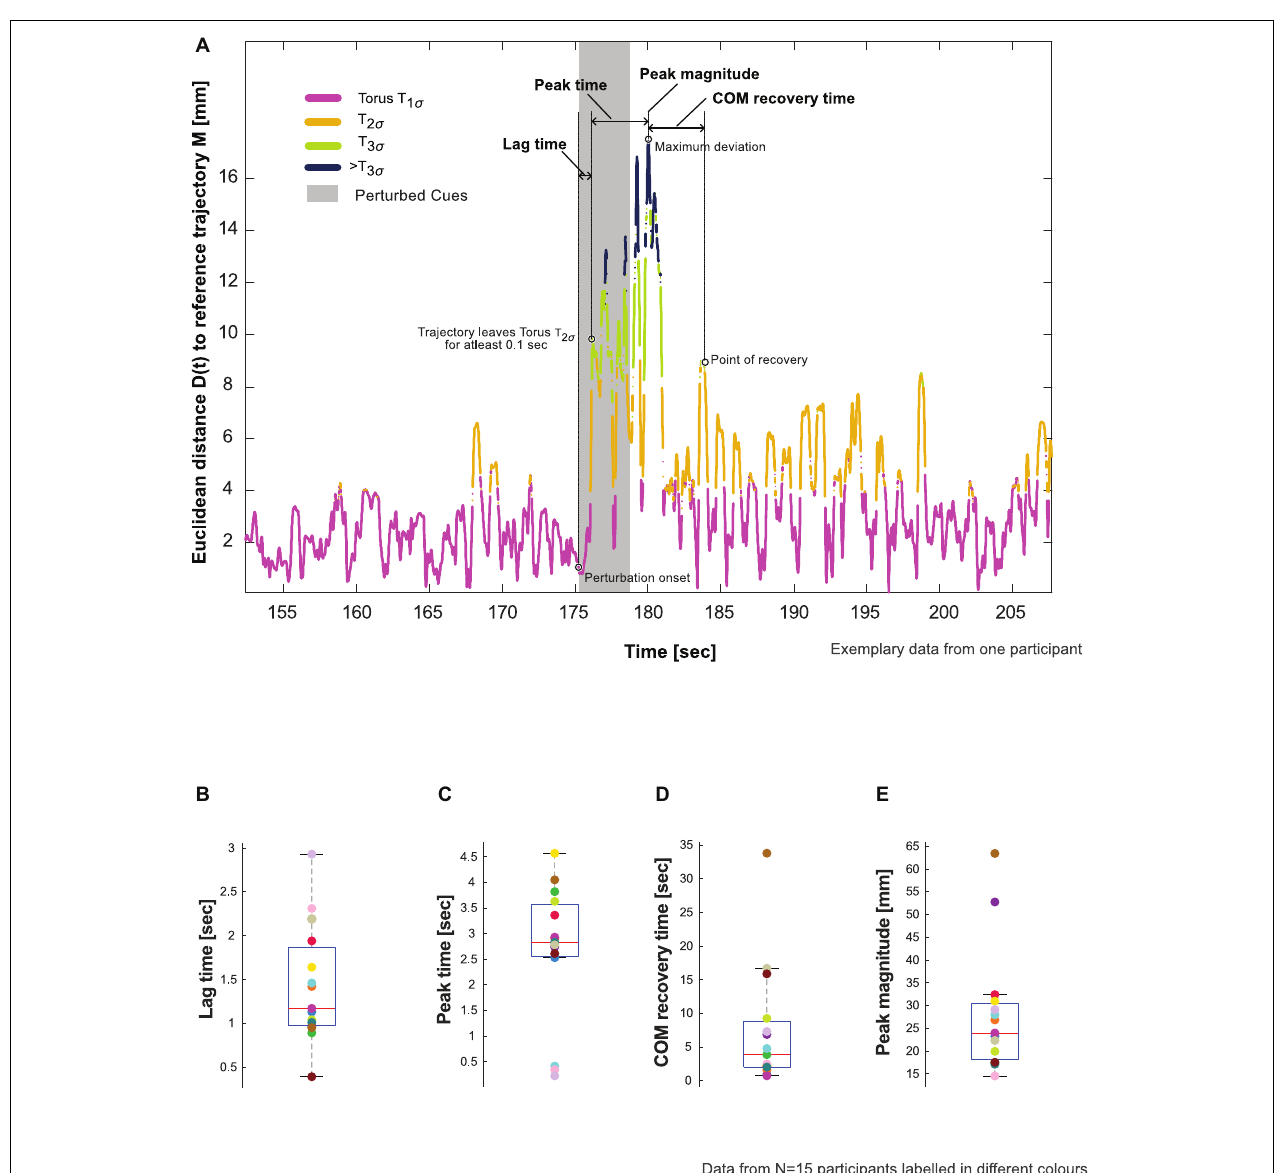
FIGURE 2 | Resilience characteristics. (A) Evaluation of lag time, peak time, center of mass (COM) recovery time, and peak magnitude in an exemplary participant who showed deviation from steady state patterns in response to the auditory perturbation. Refer to Section “Evaluation of COM Recovery Using Cued Walking” in the manuscript for the definition and calculation of these characteristics. (B–E) Showcasing aggregate data for these characteristics using box plots with median, 25th and 75th percentiles, extreme values, and data from individual participants ( N = 15).